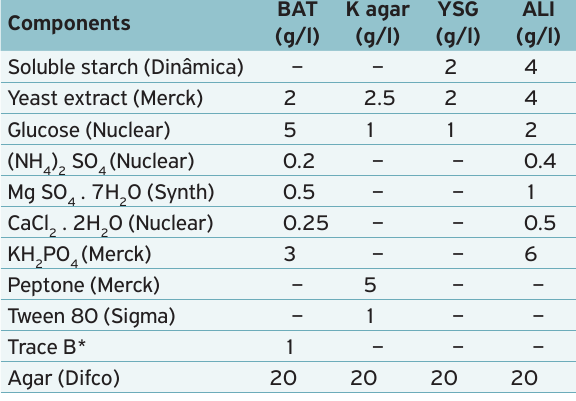
Table 1. Culture media formulation.